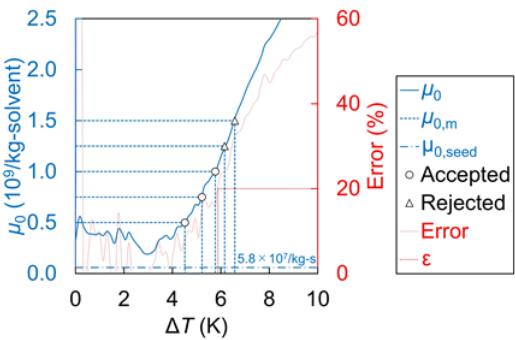
Figure 2. The data acquisition of metastable zone widths in a preliminary experiment for the secondary nucleation kinetics at the cooling rate of 1.0 K/min. The zeroth moment is denoted by the blue solid line, the thresholds of the zeroth moment by the blue dashed line, the zeroth moment of seed crystals by the blue chain line, the accepted data by the circles, the rejected data by the triangles, the error by the red solid line, and the permissible error by the red dotted line.